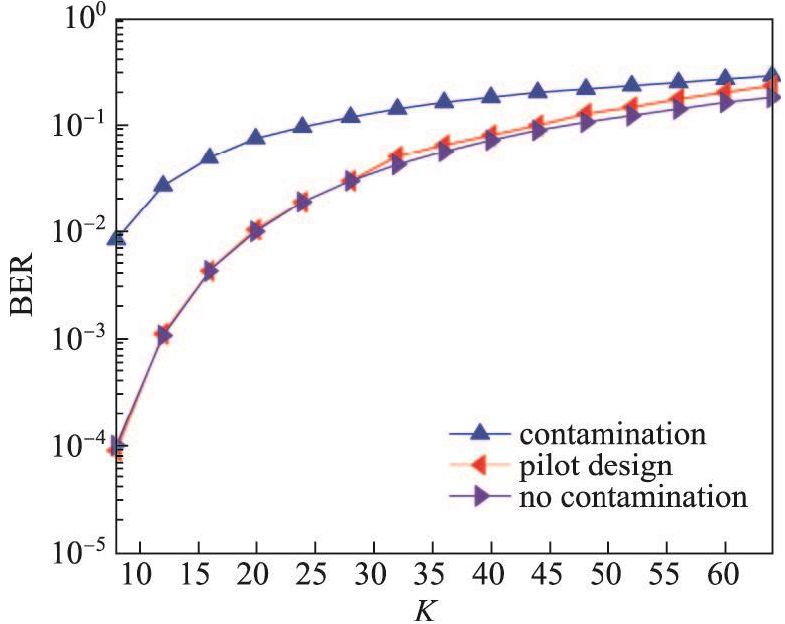
Figure 18. BER comparison against the number of cell users for the proposed pseudo-random pilot design and other cases.